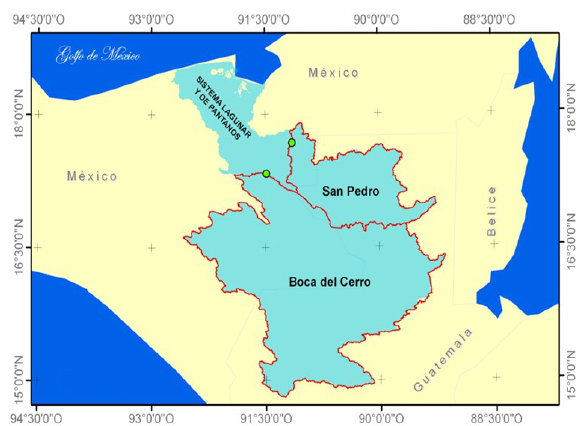
Figure 1. Study area. The location of the Catchments San Pedro and Boca del Cerro and their hydrometric stations taken as their outlets are shown. The upper part of the basin is builded by both catchments and the lower part by what is named 'Sistema Lagunar y de